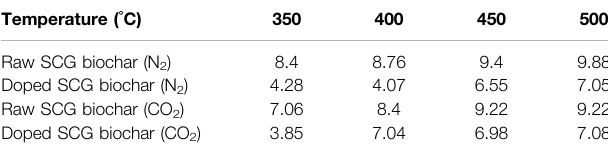
TABLE 5 | pH of SCG biochars with different pyrolytic gas. Temperature ( ° C)